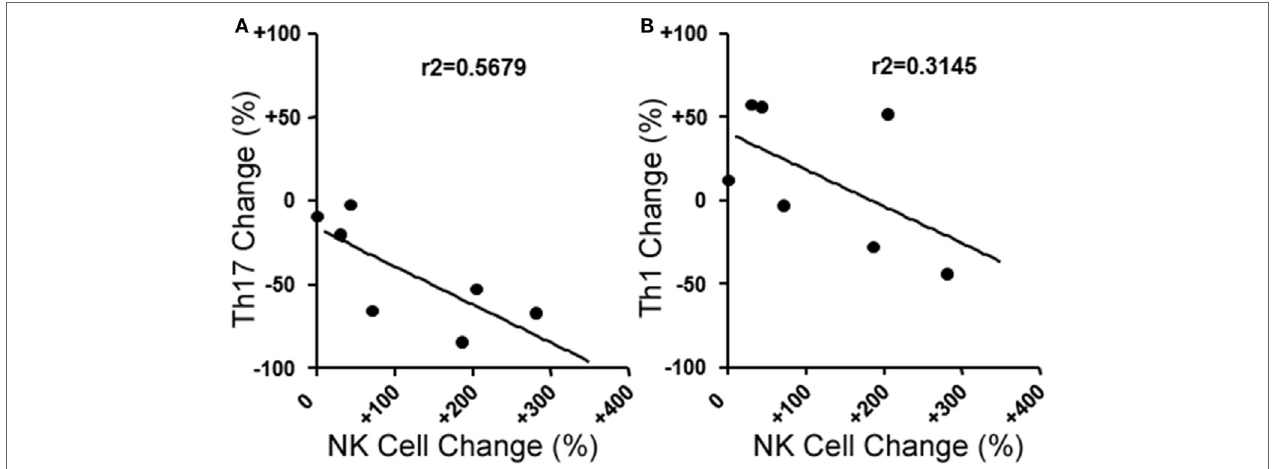
FigUre 3 | Changes in blood natural killer (NK) cell populations correlate with changes in helper T (Th) cells populations following aHSCT in MS patients. MS patient peripheral blood mononuclear cell (PBMC) samples from baseline (BL) and 12 month post-aHSCT were activated in vitro with anti-CD3, anti-CD28, and Th17 polarizing factors for 4 days. Th17 and Th1 cells were assessed by analysis of cytokine production by intracellular flow cytometry (CD3 + CD4 + IL-17A + IFN- γ − or CD3 + CD4 + IL-17A − IFN- γ + , respectively). The change in frequency of Th17 cells (a) or Th1 cells (B) was plotted against the change in NK cell frequency, and linear regression was performed on the data points. N = 7